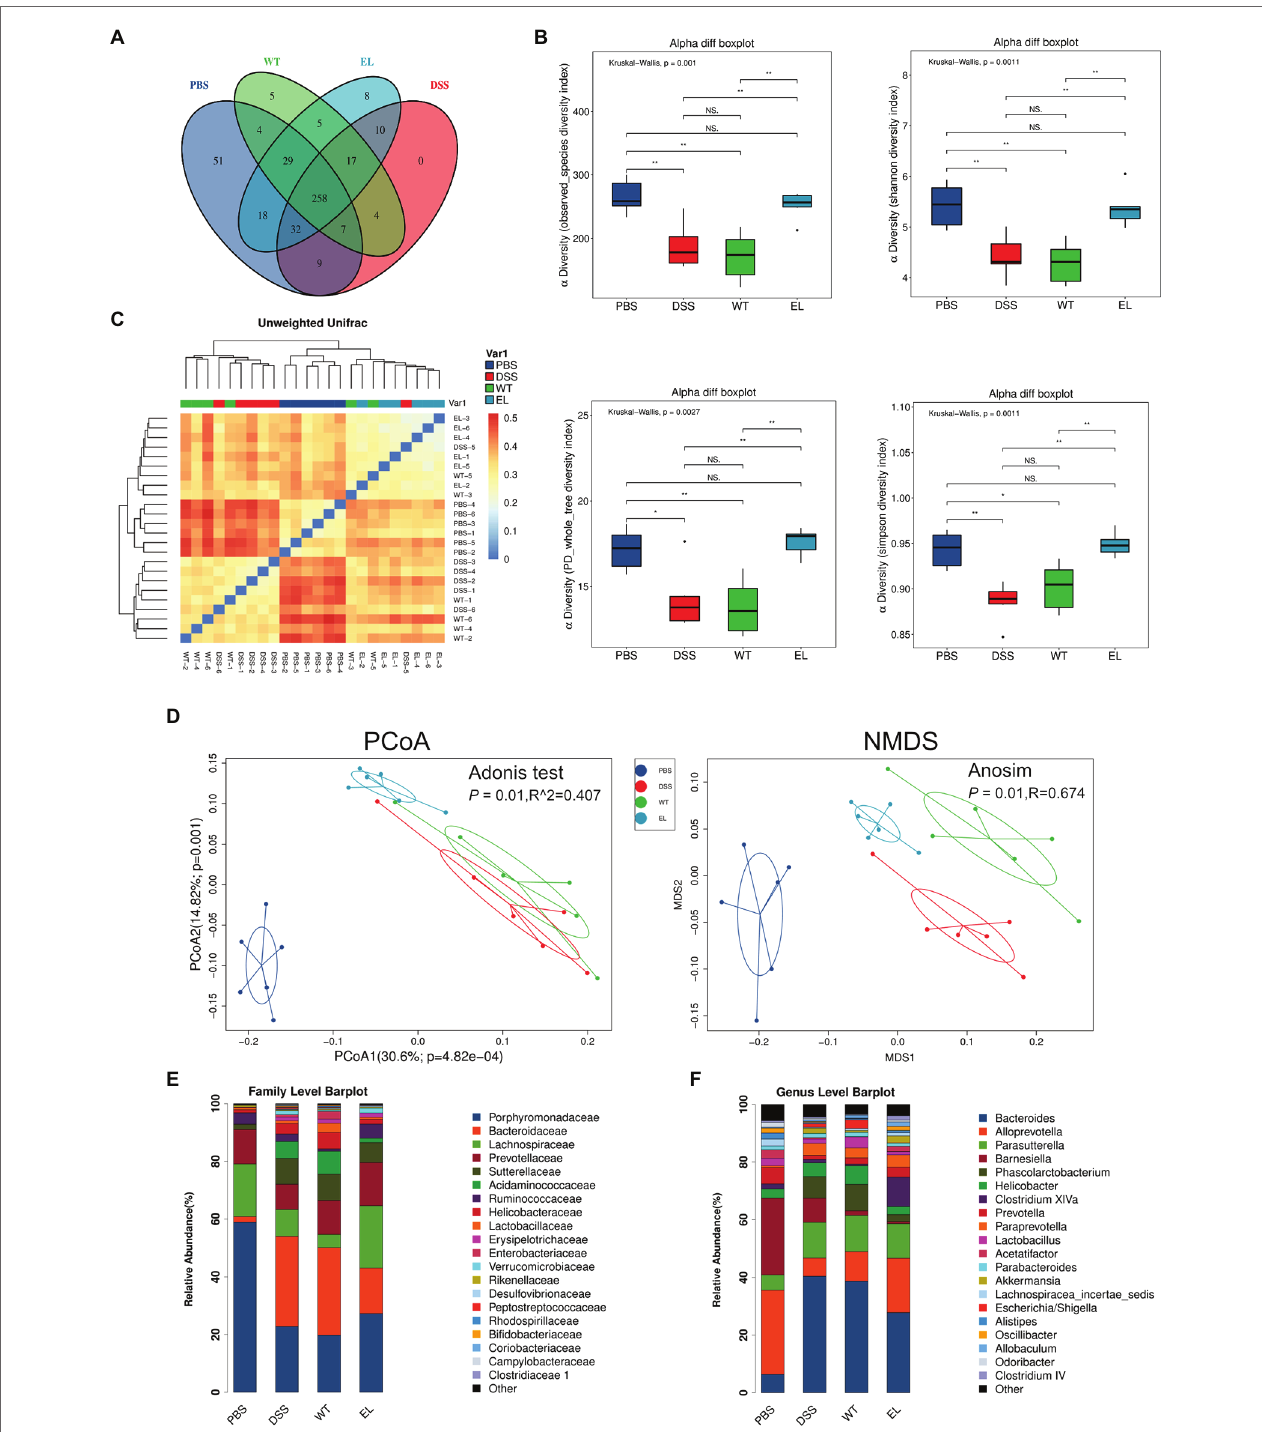
FIGURE 4 | EcN-Elafin restored the disturbed gut microbiota in DSS-induced chronic colitis mice. (A) The Venn diagram exhibiting the overlaps of OTUs from four groups; (B) α -diversity was calculated by the observed-species diversity, PD-whole-tree diversity, and Shannon and Simpson indices. ns: not significant. * p < 0.05 and ** p < 0.01 by Mann–Whitney test; (C) Heatmap with clusters displaying the results of unweighted Unifrac analysis among four groups (D) β -diversity analysis of the gut microbiota of each group. Ordination plots based on the PCoA and NMDS analysis using unweighted UniFrac. (E , F) Relative abundances of bacterial taxa at the family and genus level. n = 6 per